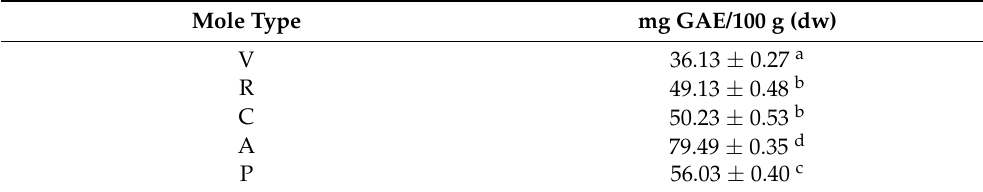
Table 6. Total phenolic content in five mole types from Hidalgo state,